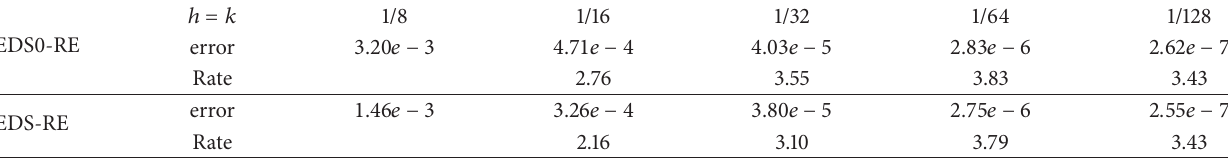
Table 4: Maximum absolute errors and rate of EDS0-RE and EDS-RE, Example 8 with 𝑃 = 100 . EDS0-RE